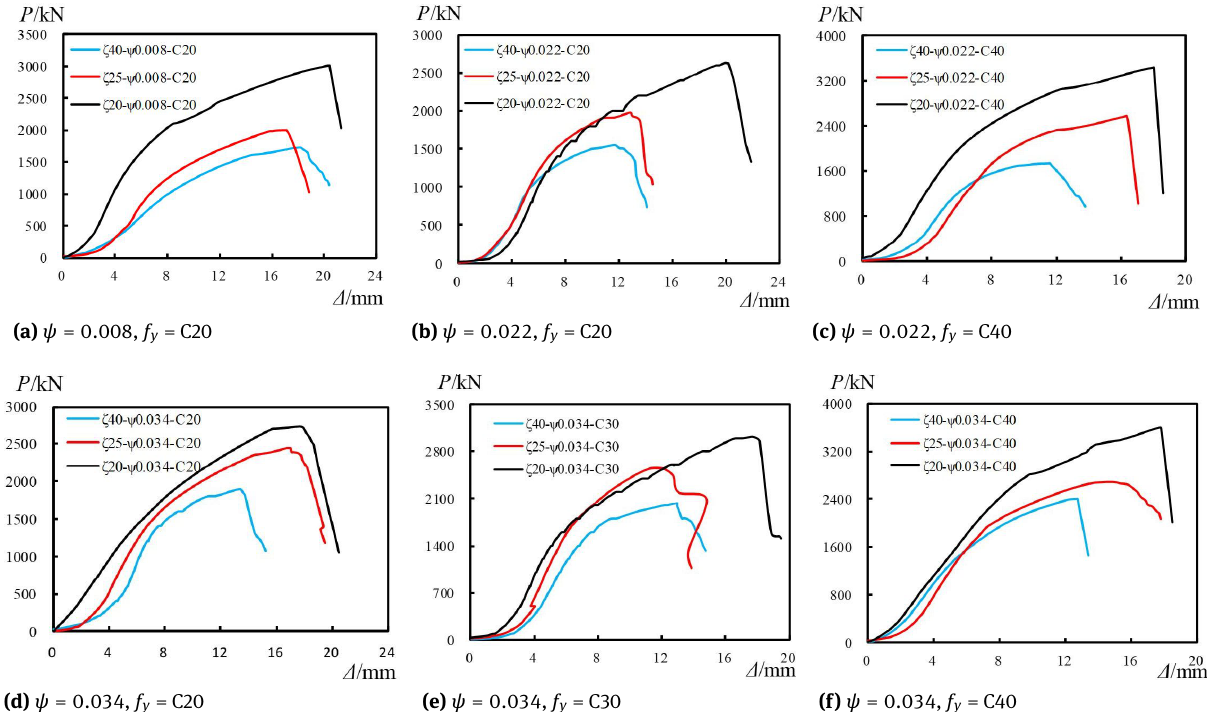
Figure 11: Typical load-displacement curves under different diameter-to-thickness ratio of GFRP tube